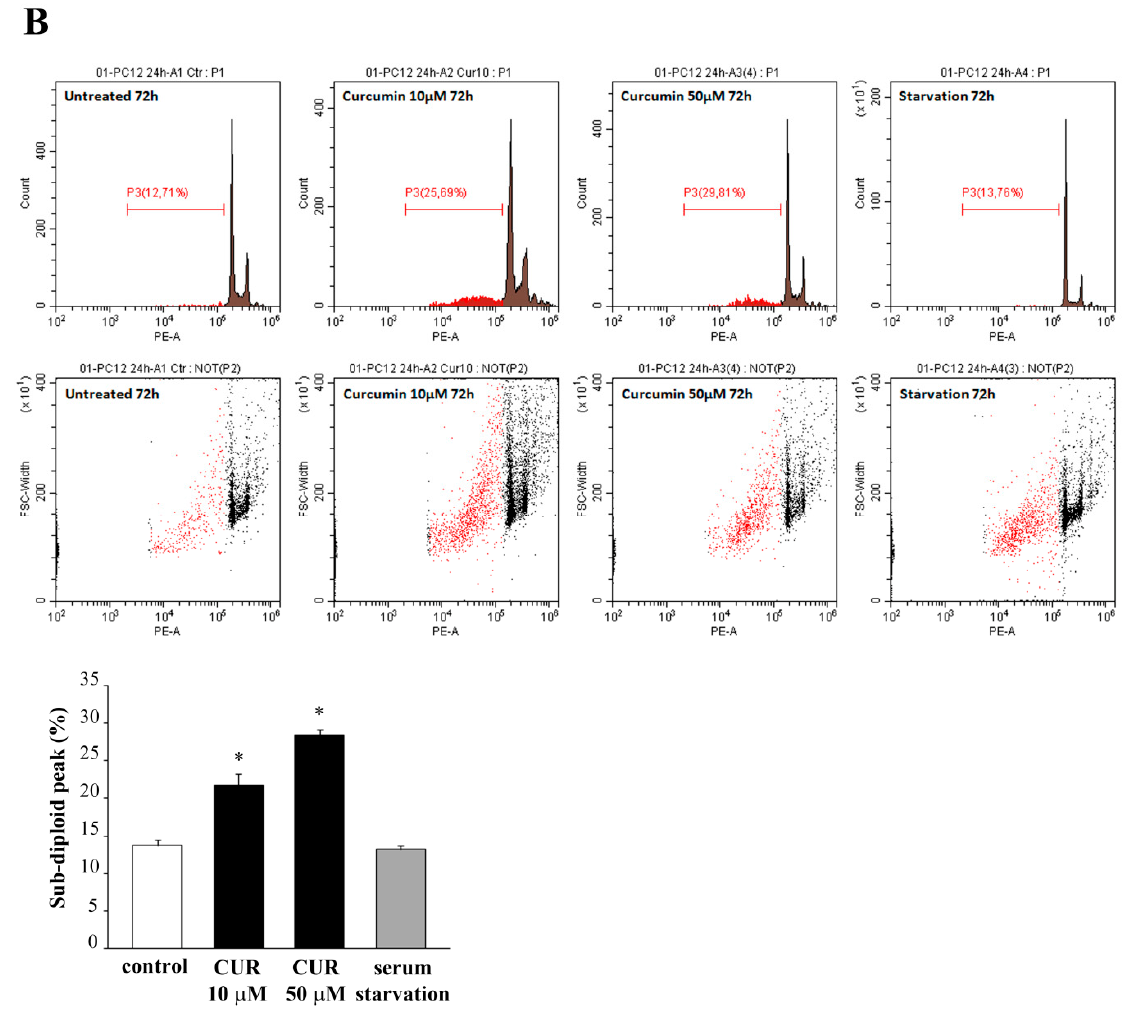
Figure 3. CUR induces apoptosis. Representative flow cytometry profiles and the related histogram reporting the sub-G1 peak after treatment with CUR for ( A ) 24 h (50 µ M) and ( B ) 72 h (10 µ M and 50 µ M), compared with untreated control cells. Data related to serum starvation were shown as positive control. * p ≤ 0.05 compared with control.